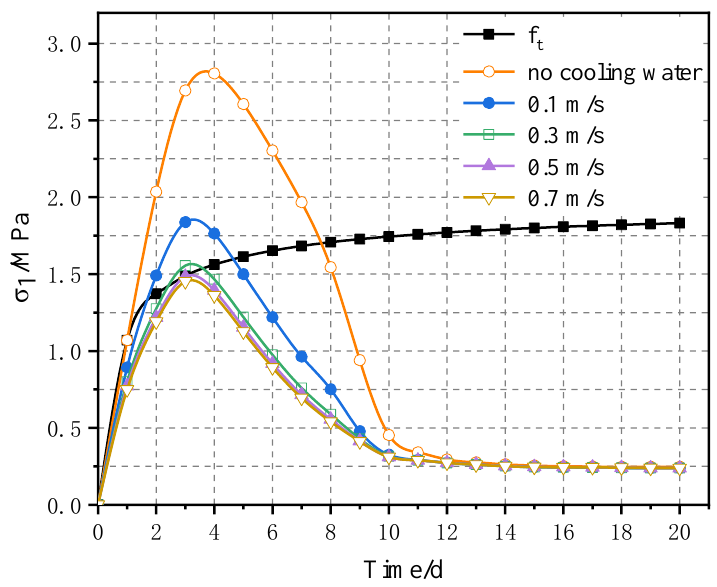
Figure 6. Stress duration curve of characteristic point d under different working conditions.